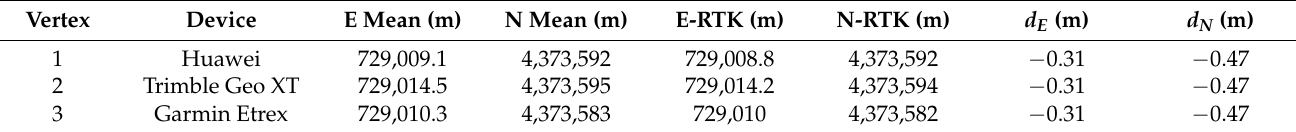
Table 8. Vertices 1, 2, and 3: East, North coordinates obtained from Equation (27), East, North coordinates from real-time GNSS techniques (E-RTK, N-RTK) and the differences between ( d E , d N ).